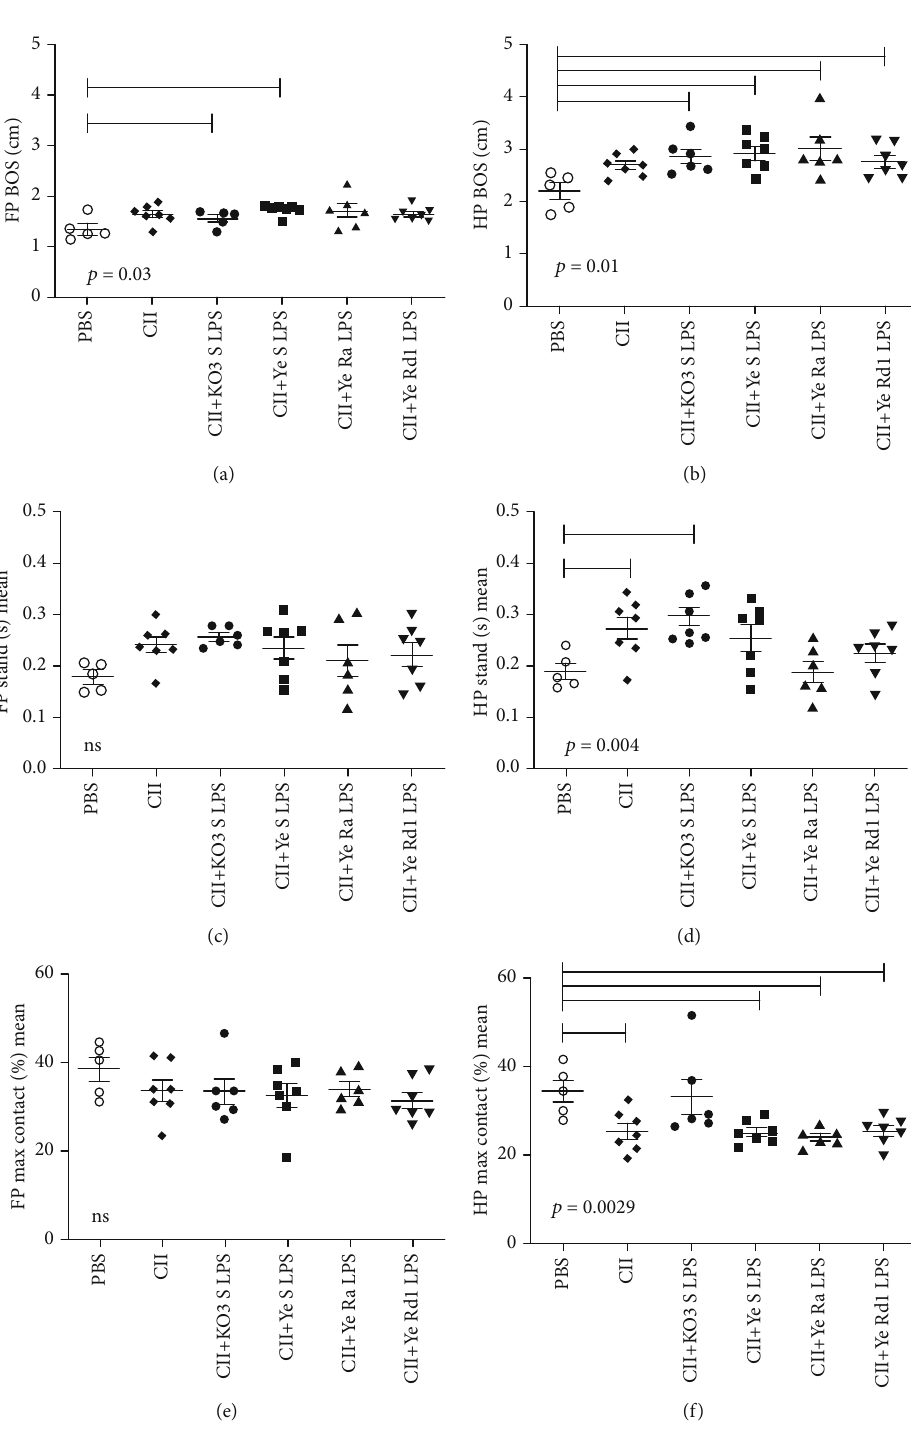
Figure 2: CatWalk gait analysis of mice injected with PBS, collagen type II, and the mixture of CII and tested LPS. Individual values from 5 (negative control, PBS) to 7 animals and means ± SEM are demonstrated. Statistically signi fi cant di ff erences in comparison with baseline: p < 0 : 05 (one-way ANOVA followed by Dunnett ’ s multiple comparison test). FP/HP span, FP/HP stand (s) mean, and FP/HP max contact (%) mean were analyzed. Base of support (BOS): the average width between either the front paws or the hind paws; Stand (s): the duration of contact with the glass plate of the print, or is the duration in seconds of contact of a paw with the glass plate; Max contact at (s): the time in seconds since the start of the run that the largest part of the print makes contact with the glass plate. The individual values, means, and SEM are presented. Horizontal lines show the statistically signi fi cant di ff erences between analyzed